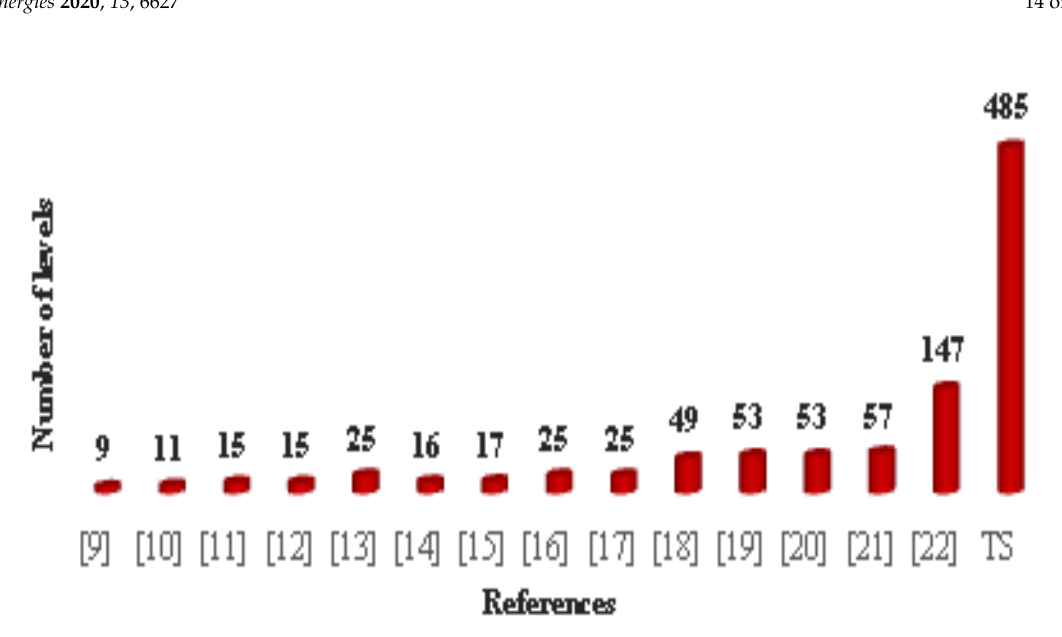
Figure 8. Comparison in terms of the number of voltage levels.